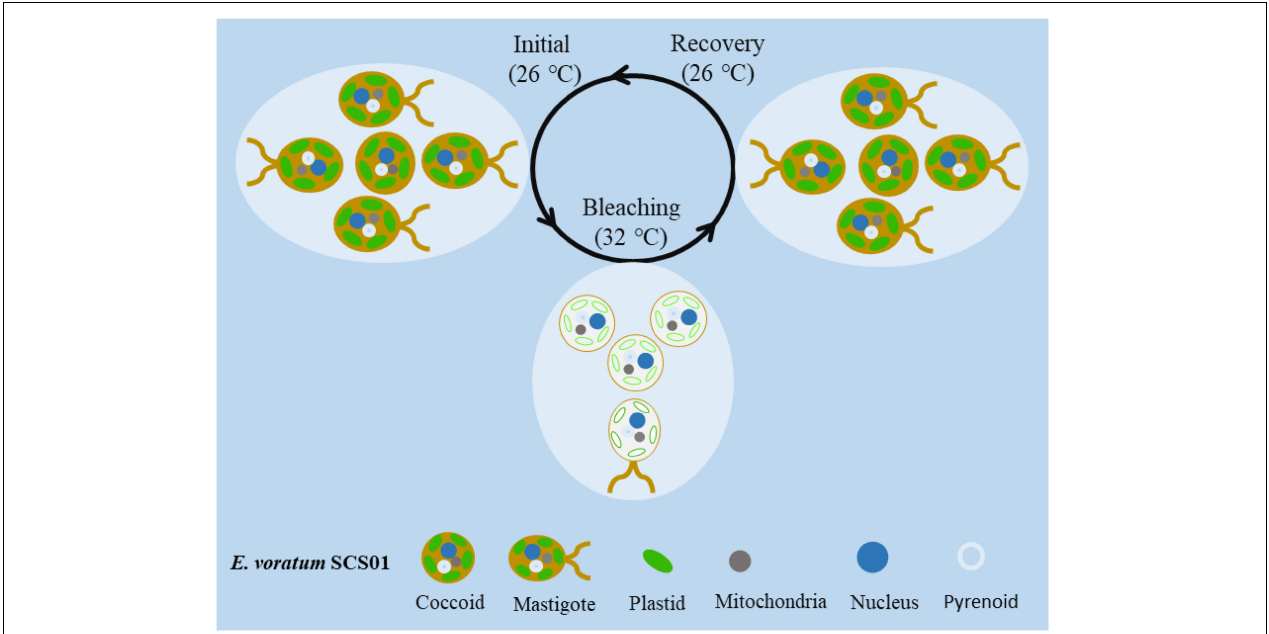
FIGURE 5 | A proposed model of photobleaching and life form transformation in seawater and host cells following short-term thermal stress-induced bleaching and